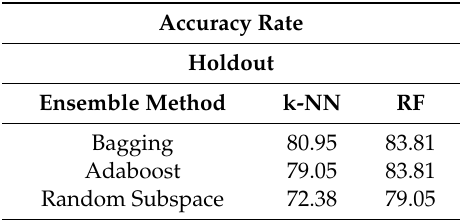
Table 13. Overall performance measure ensemble classifiers for holdout method.